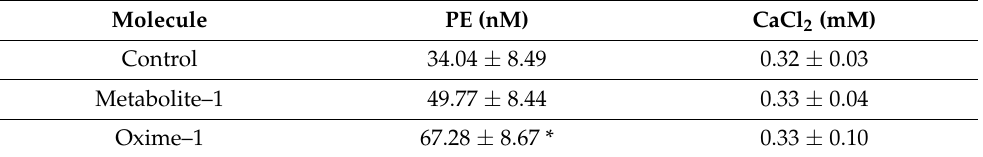
The values represent the half maximal effective concentration (EC 50 µ M) to PE or CaCl 2 . The values are mean ± standard error of the mean (SEM) of 4 independent experiments. Statistically significant difference: * p < 0.05 vs. control.